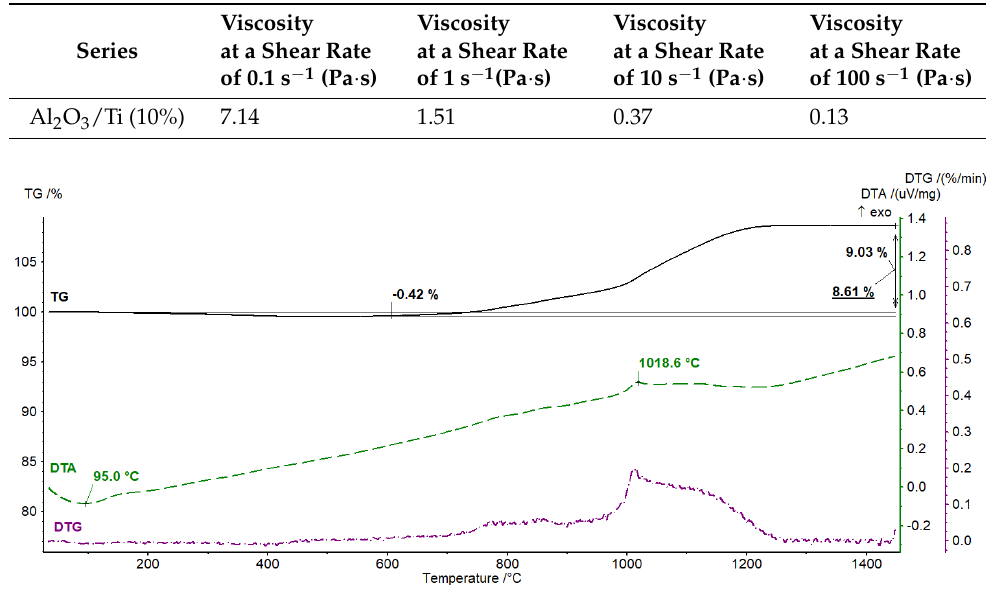
Figure 5. Thermal analysis results—DTA, TG and DTG